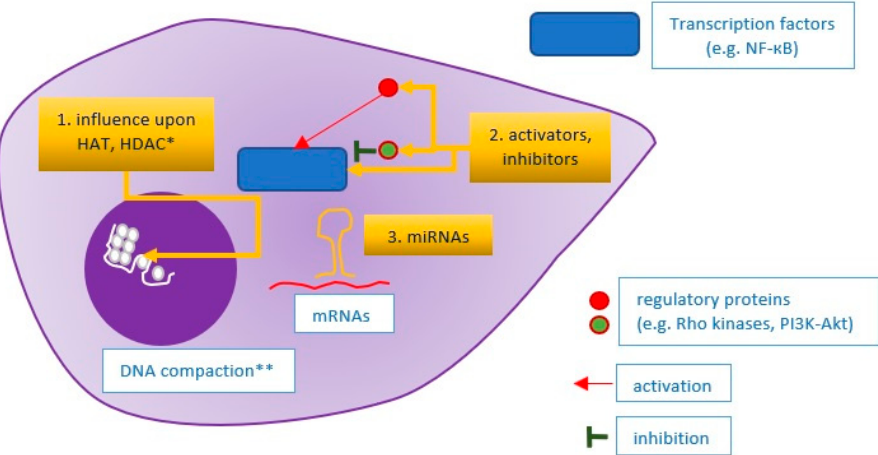
Figure 4. Idea of an integrative approach towards atherosclerotic plaque stabilization. 1. Influence upon mechanisms that are responsible for chromatin compaction and DNA accessibility for transcription machinery; 2. Activation or inhibition of transcription factors, regulating gene expression in the nucleus; 3. Influence upon miRNAs, i.e., particles that inhibit specific mRNA particles in the mechanism of complementarity. * HAT: histone acetyltransferase; HDAC: histone deacetylase; ** DNA compaction relies on nucleosome methylation or acetylation (regulated by HATs and HDACs).